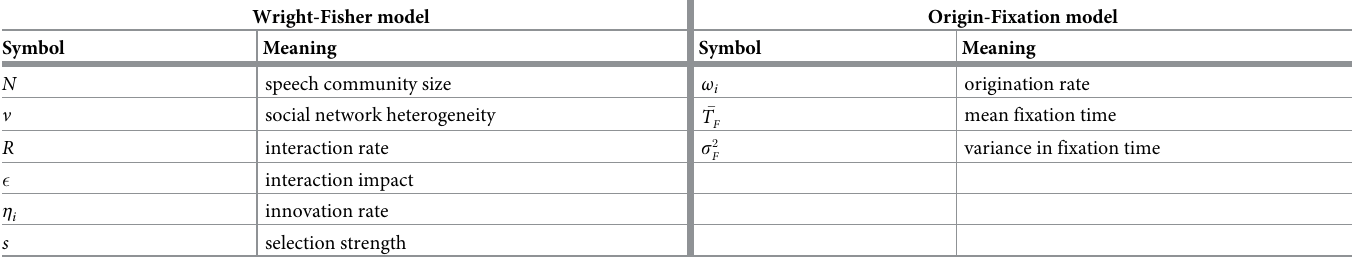
Table 2. Parameters in the individual-based Wright-Fisher and population-level origin-fixation